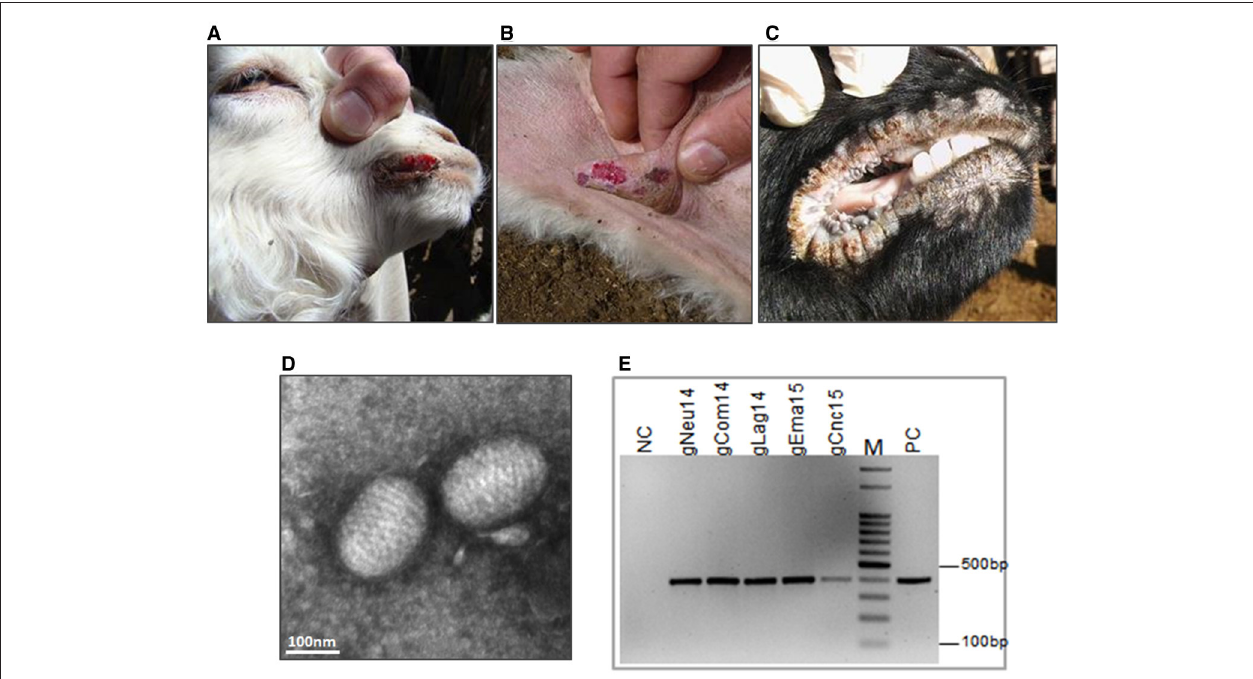
FIGURE 2 | Ecthyma outbreaks: clinical diagnosis and molecular confirmation. Contagious Ecthyma in Angora goats from Comallo outbreak: lesions in lips (A) and udder (B) . (C) Lesions in lips from Creole goats from the Concaran outbreak. (D) Electron microphotograph showing the characteristic morphology of a parapoxvirus virion from El Manantial scabs (bar = 100nm). (E) Confirmatory PCR, detection of ORFV genome in all analyzed samples. NC, negative control; PC, positive control; M, DNA ladder 100 bp.